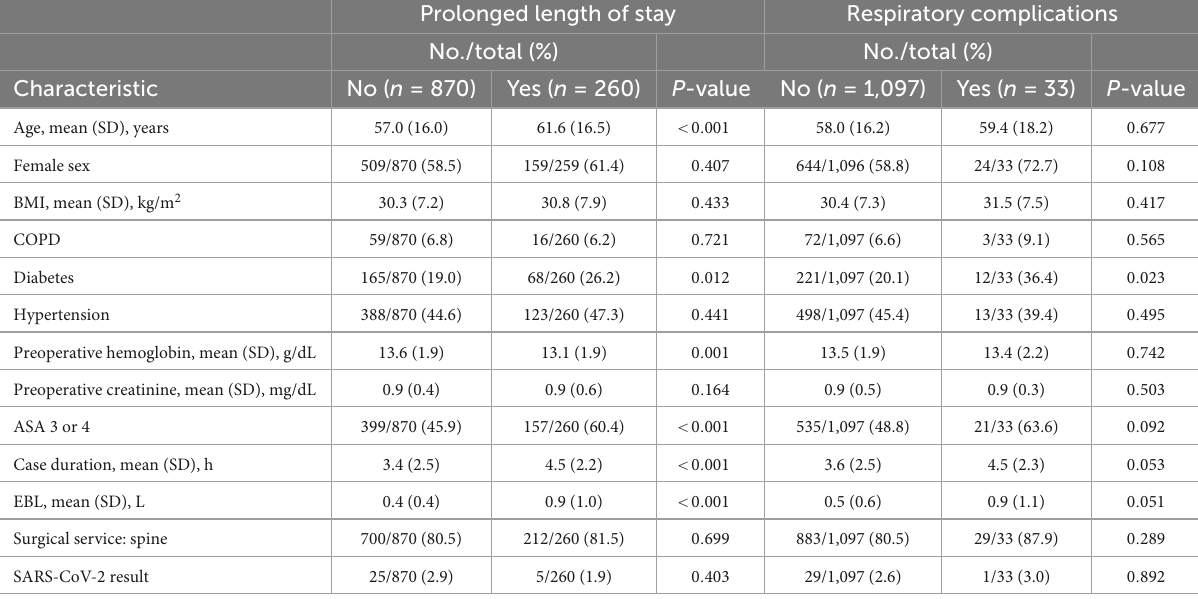
TABLE 2 Univariate analyses identifying potential predictors of prolonged length of stay and respiratory complications.